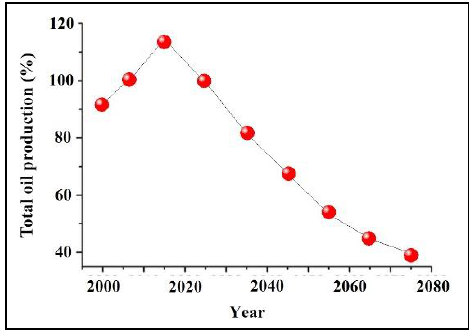
Figure 1. World oil production forecast based on present demand scenario.